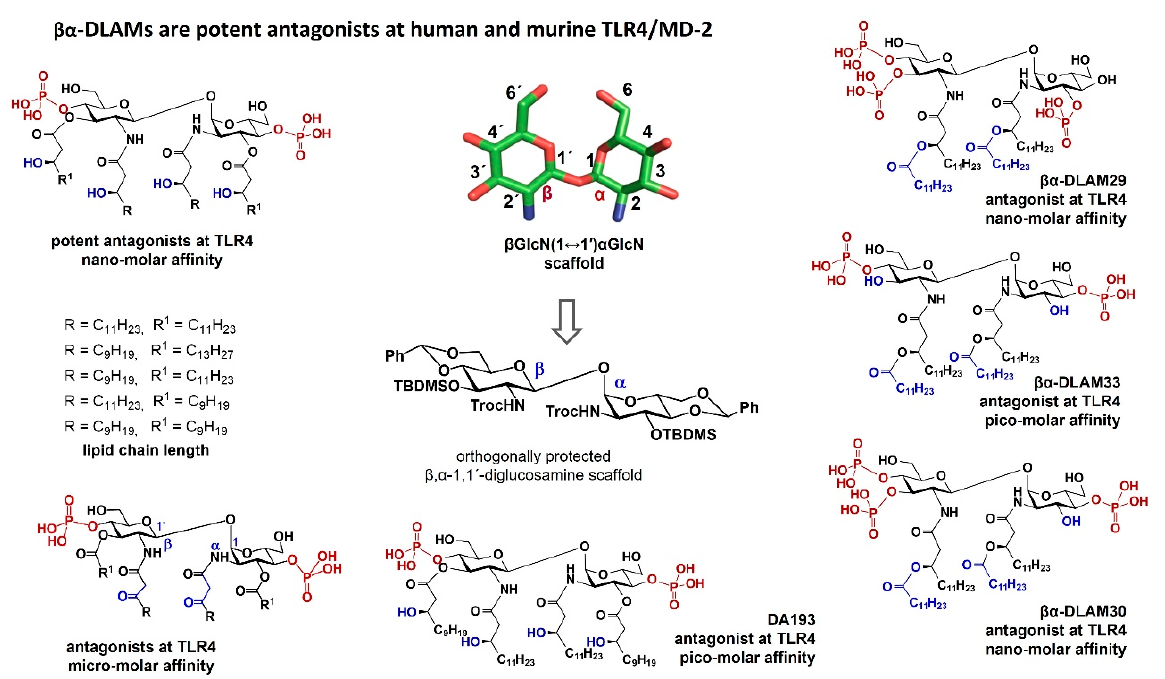
Figure 7. Synthetic disaccharide lipid A mimetics derived from β GlcN(1 ↔ 1) α GlcN disaccharide ( βα -DLAMs).